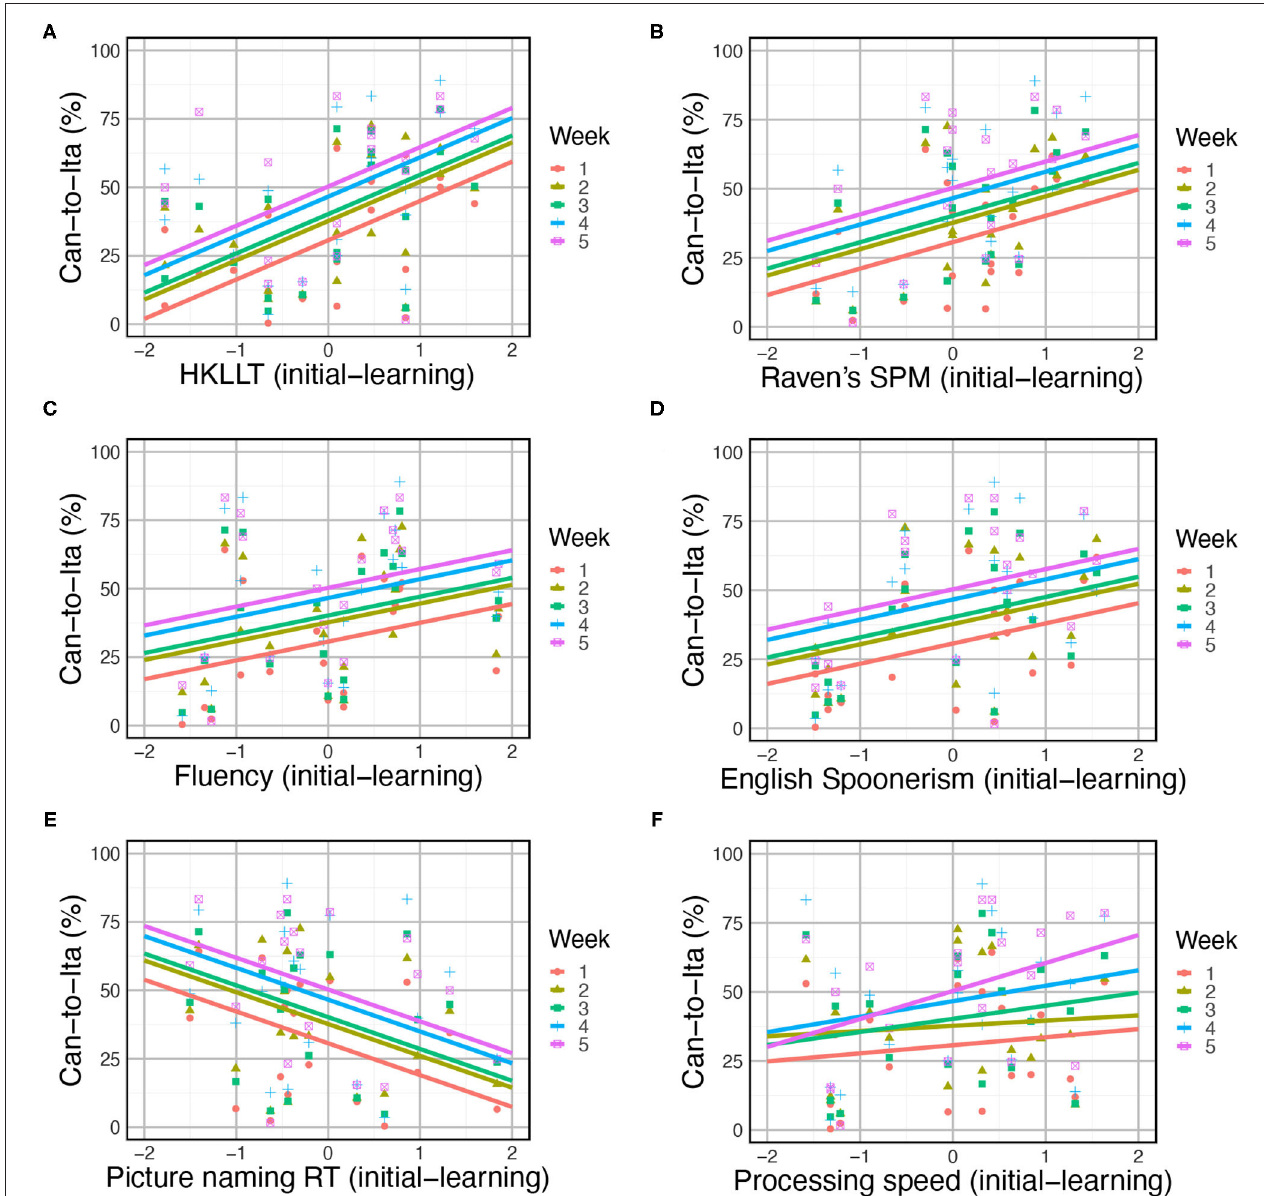
FIGURE 7 | Modulation of in-class Can-to-Ita score by cognitive predictors, including (A) HKLLT, (B) Raven’s SPM, (C) semantic fluency, (D) English Spoonerism, (E) picture naming, and (F) processing speed. Each point represents the score of one participant at a certain week, and the solid lines are the fitted data based on the LME